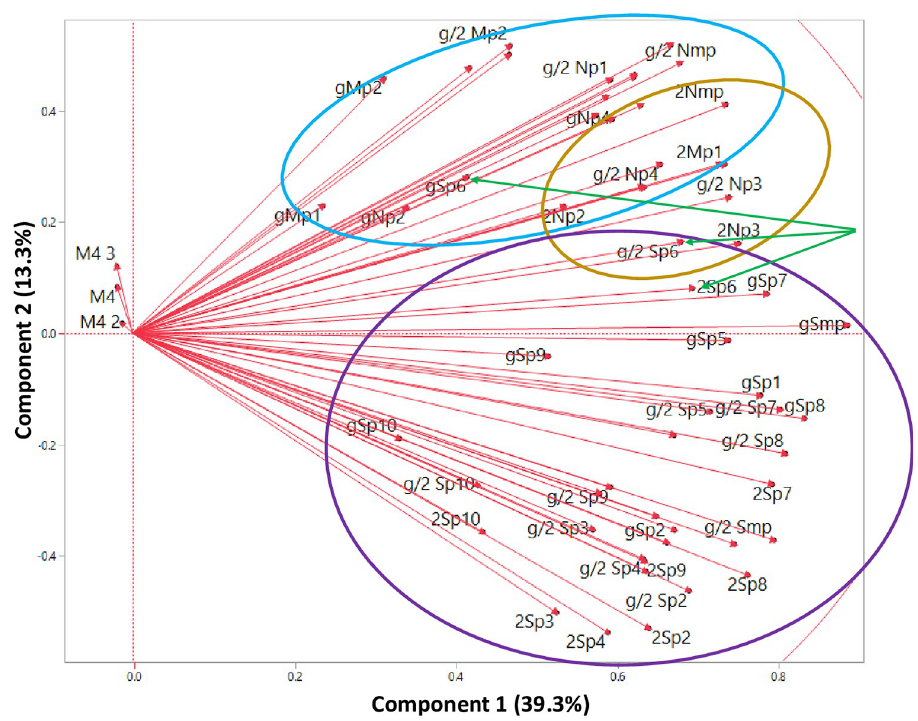
Fig 4. Hierarchical distribution of IFN- γ , IL2, and IFN- γ +IL2 responses to S, N, and M peptide subpools. Responses to each stimulant were used, including to all 10 S subpools, all 4 N subpools and each M subpool. In addition, responses to megapools each containing all S, or N, or M peptides combined into one pool, Smp, Nnp, and Mmp respectively, were also used. IFN- γ responses (g), IL2 responses (2), IFN- γ +IL2 responses (g/2). When Components 1 and 2 are compared, responses to Medium only (M4, M4 2 and M4 3) fell outside this correlation. However, S and M peptides fall within distinct aggregate areas defined by purple or blue circles respectively, although responses to N protein (gold circle) overlap the S and M protein areas. S glycoprotein peptide subpool Sp6 falls within each aggregated area (green arrows): IFN- γ (gSp6), IL2 (2Sp6), IFN- γ +IL2 (g/2Sp6).